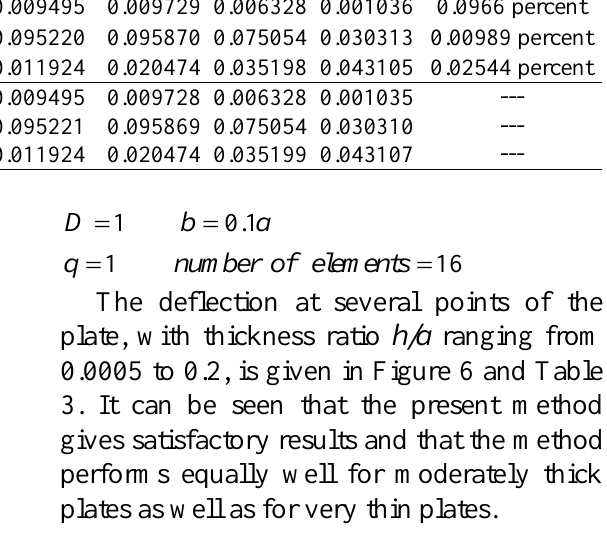
Fig. 5. Rotation along radius for simply supported annular plate ( b = 0.1 a , h = 0.02 a ) Table 2. Simply supported annular plate under uniformly distributed load ( a = 1, b = 0.1 a , h = 0.02 a ) r = 0.2